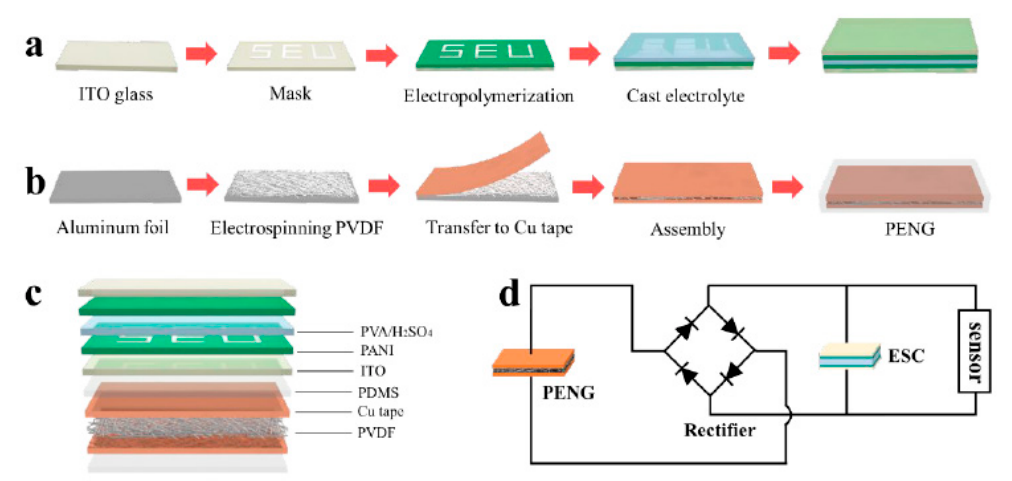
Figure 23. Schematic illustration of the self-powered patterned electrochromic supercapacitors (ESC). ( a ) The fabrication process of the patterned ESC. ( b ) The preparation process of the wearable piezoelectric nanogenerator (PENG). ( c ) Schematic depiction of the self-powered patterned ESC in a layer by layer format. ( d ) The equivalent circuit of the self-powered patterned ESC. Reprinted with permission from [157].